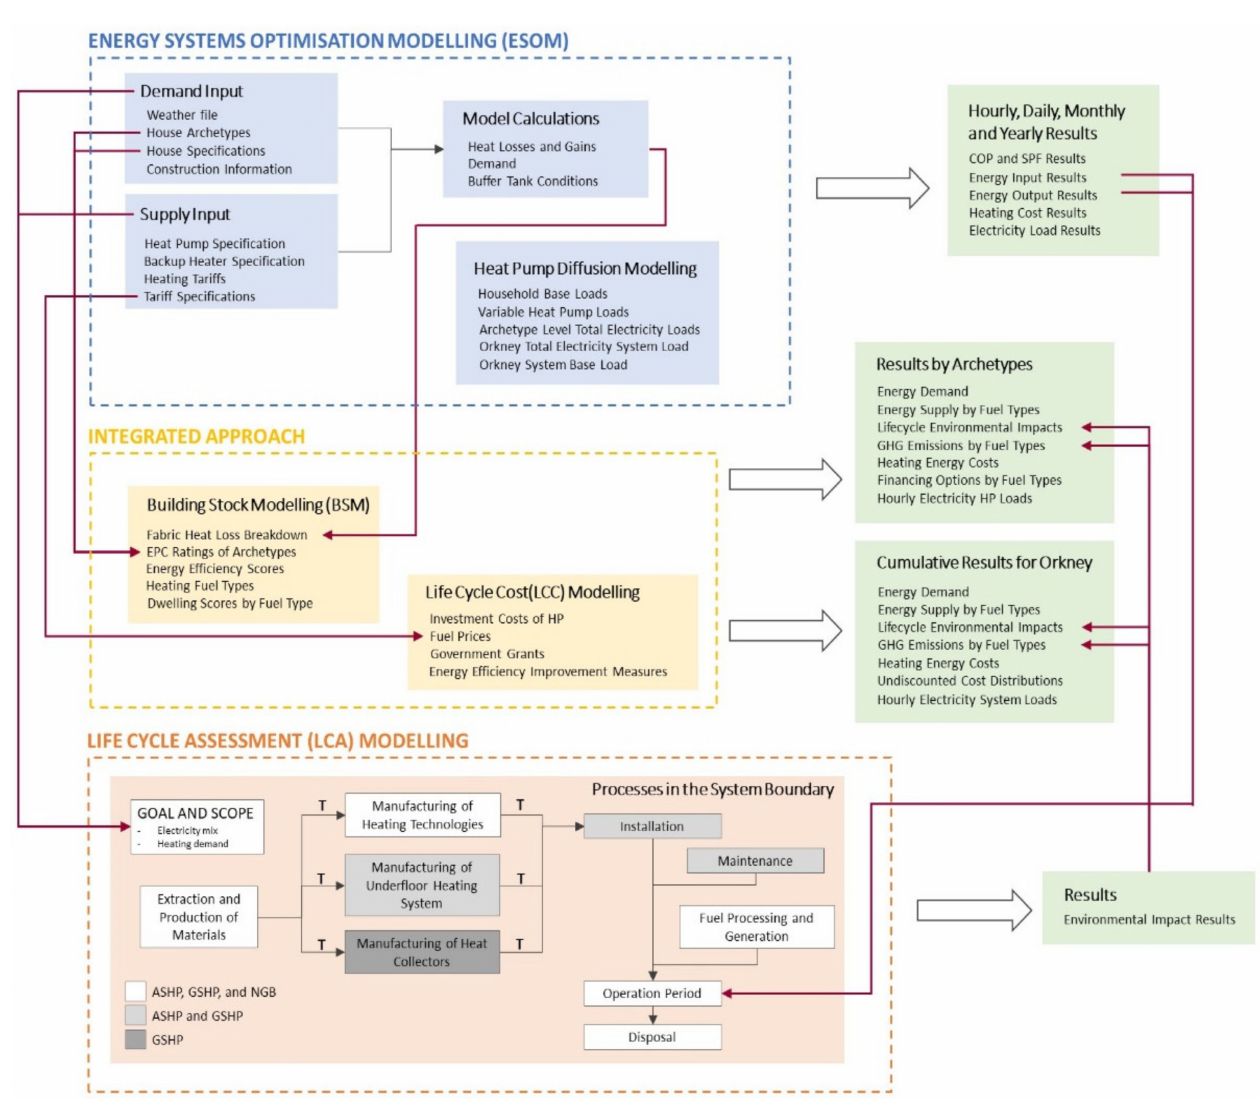
Figure 1. A schematic diagram of the proposed integrated